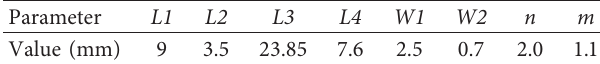
Figure 3: Multilayer structure of the RPA. (a) 3D structure. (b) Pixel parasitic layer (top view). (c) Driver layer (down view). Table 1: Geometrical parameters of the RPA.